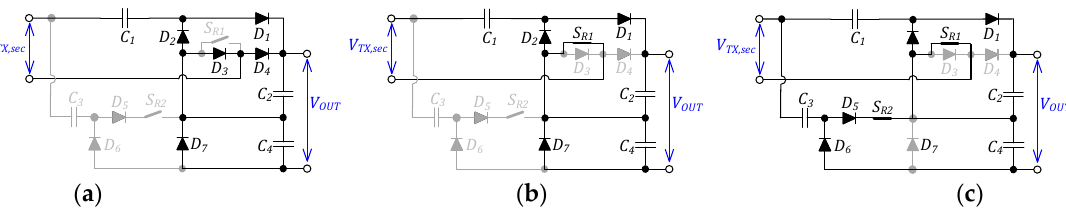
Figure 3. Equivalent circuits of the 3-mode reconfigurable rectifier: FBR mode ( a ), VDR mode ( b ), and VQR mode ( c ).